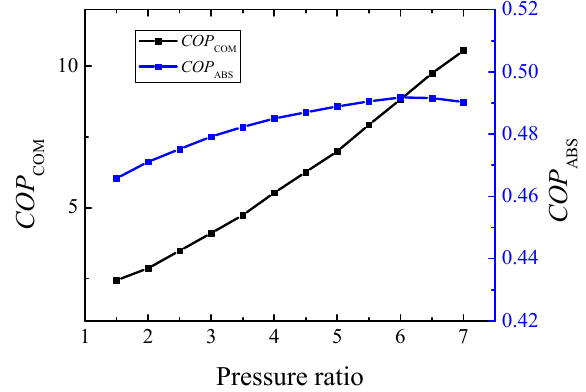
Figure 15. Optimal sub-cycle COP under different pressure ratios.